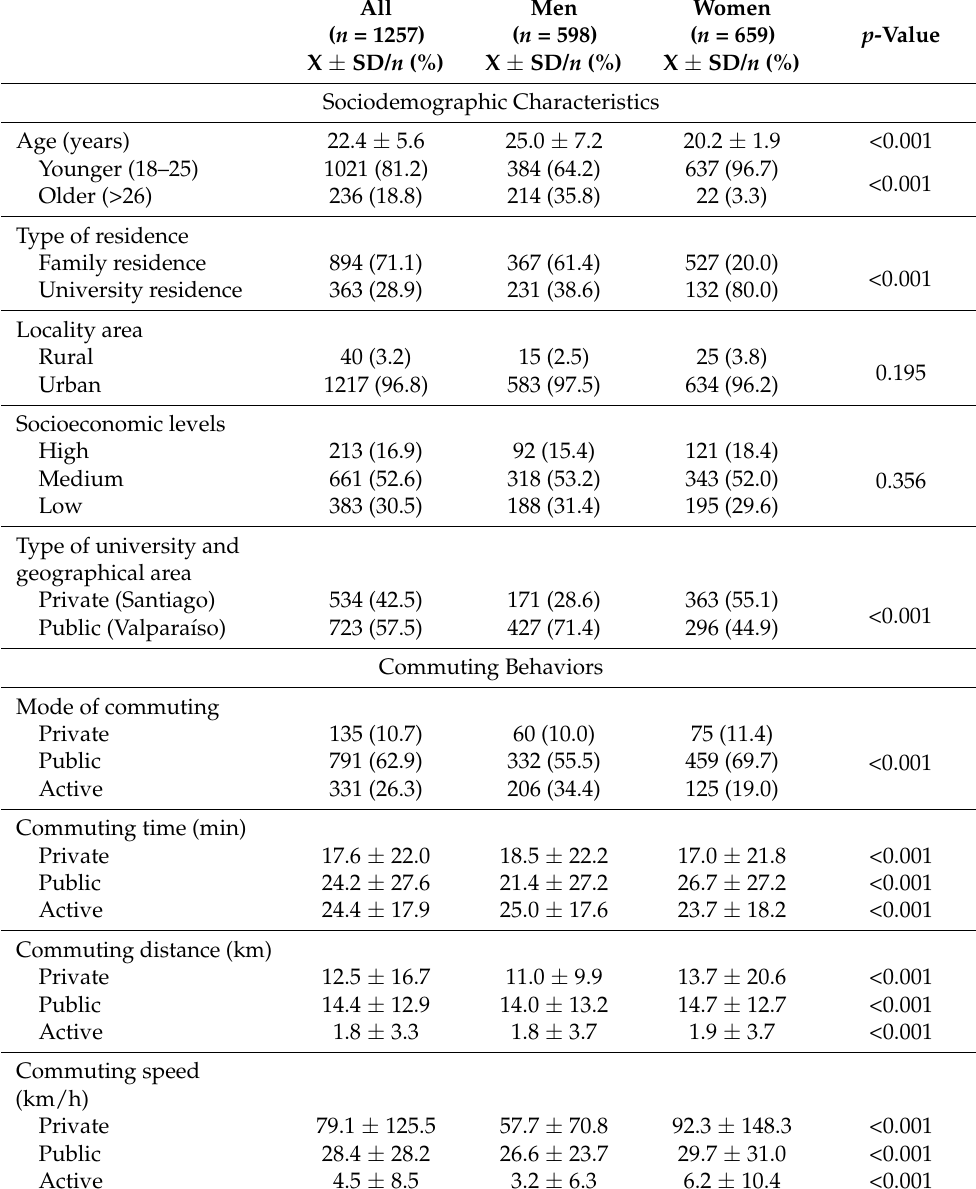
Table 1. Sociodemographic characteristics and commuting behaviors of participants by gender.